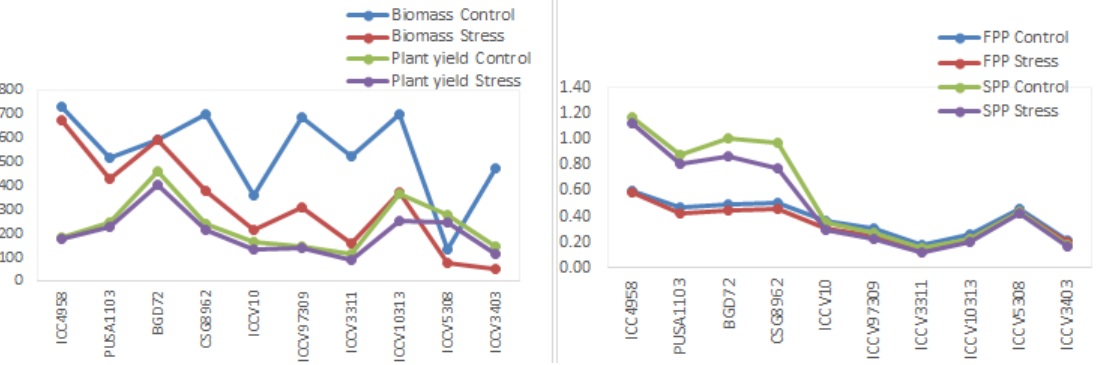
Figure 5. Effect of water stress on yield and yield traits of tolerant genotypes; FPP, filled pods per plant; SPP, seeds per pod.